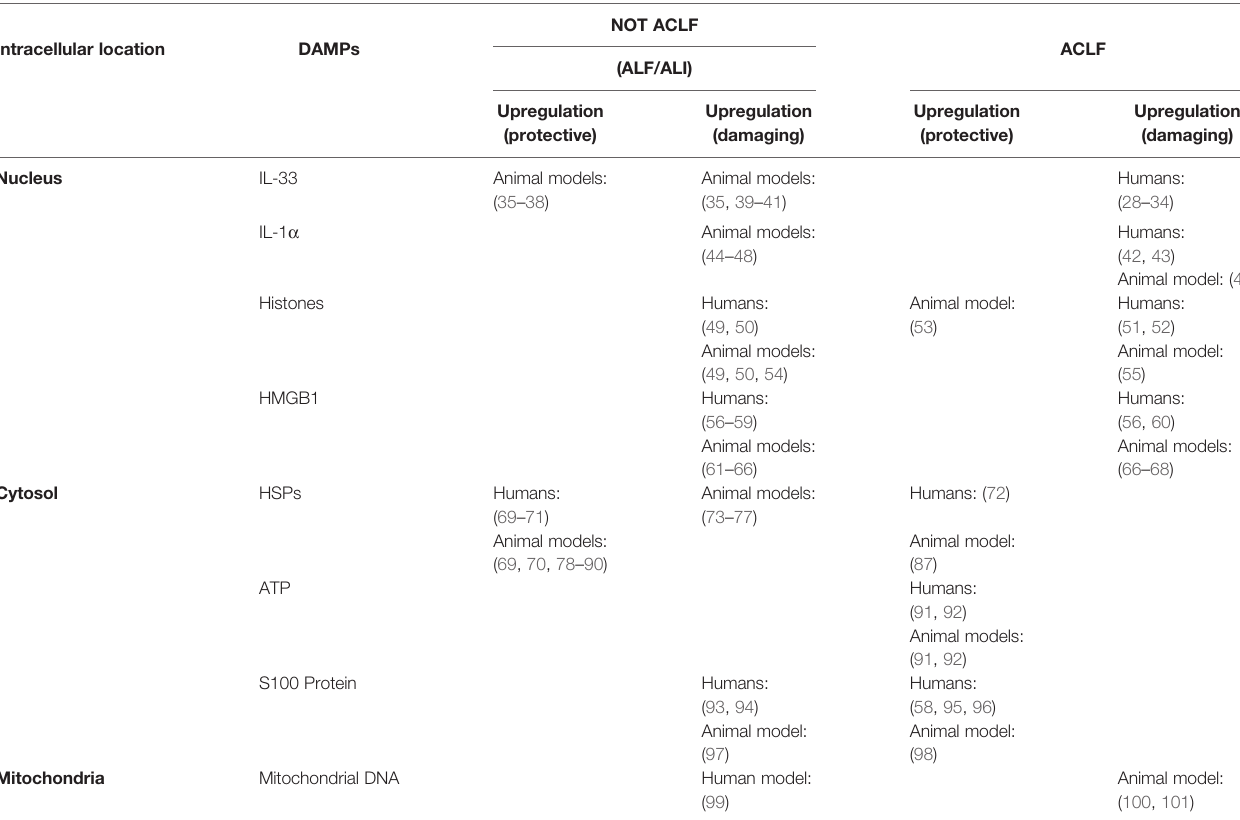
TABLE 1 | DAMPs associated with ALF.